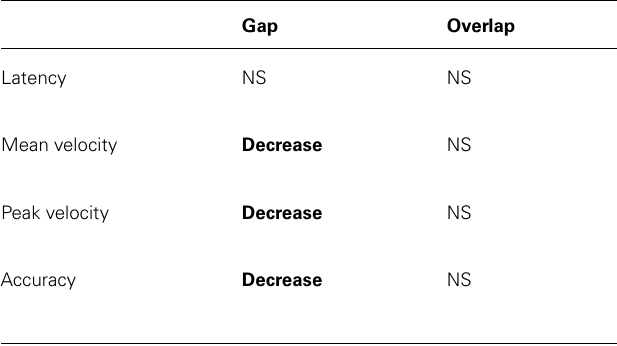
Table 4 | Summary of the statistically significant results (in bold) for the repetition effect of task